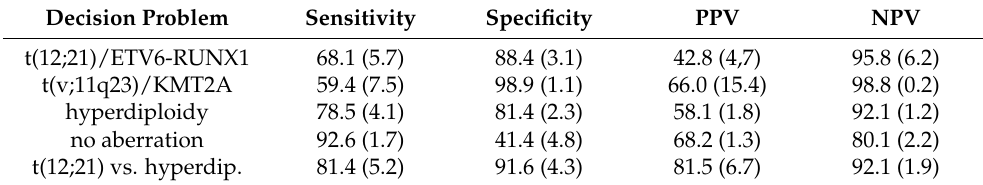
Table 3. Classification efficiency